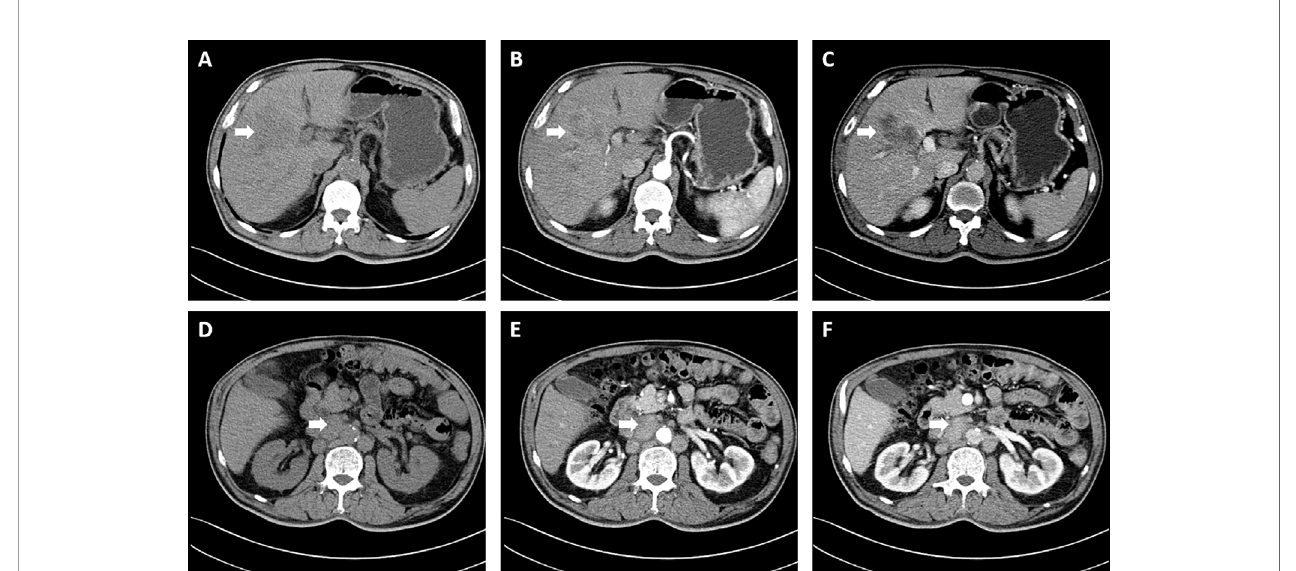
FIGURE 2 | Computed tomography revealed an irregular morphology mass (49 mm * 39.6 mm) in the liver; the hepatic portal and retroperitoneal lymph nodes were enlarged. (A, D) Plain scan; (B, E) Arterial phase; (C, F) Portal venous phase. The white arrowheads direct the lesion or enlarged lymph